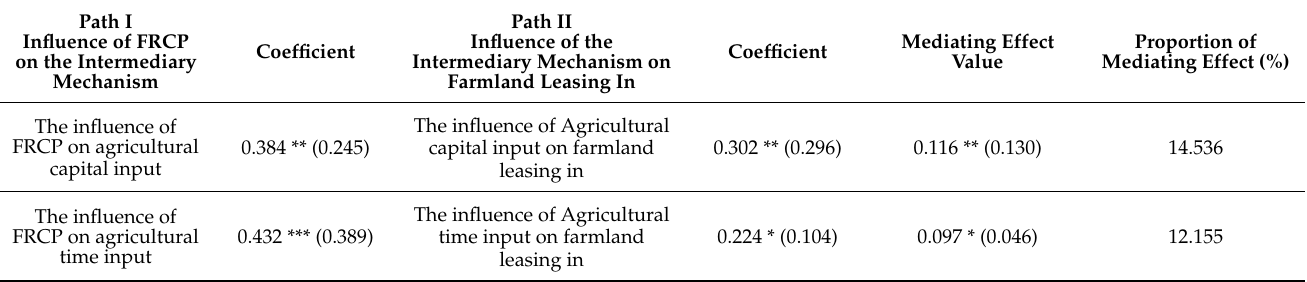
Table 6. The impact of FRCP on the transfer in of farmland: an analysis of the mediating